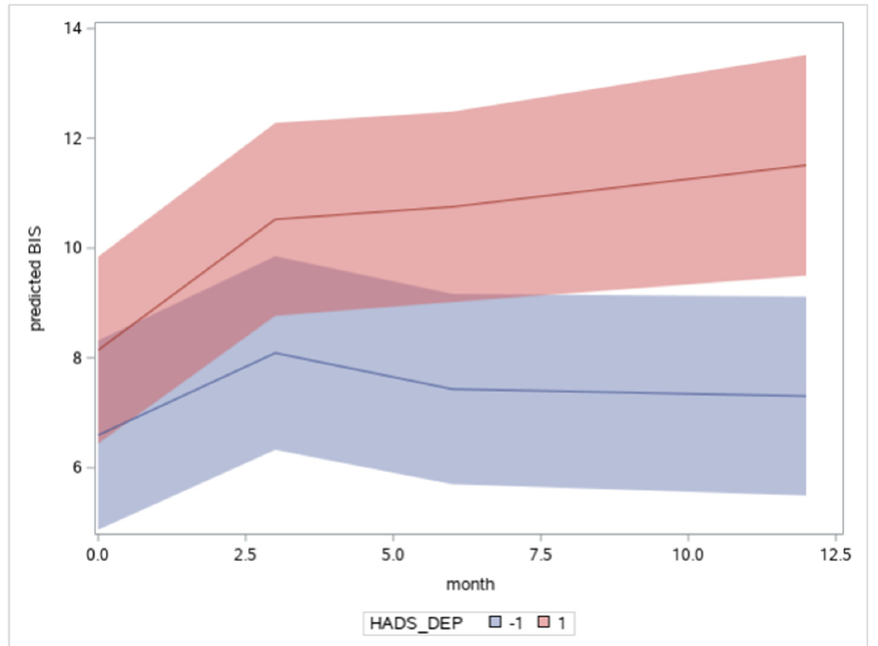
Figure 4. Plot of the Time × Depression interaction as a function of months. Note. The blue line estimates the growth curve of individuals with depression scores − 1 SD below the mean and the red line +1 SD above the mean, controlling for other factors. Shaded regions indicate the 95% confidence limits.